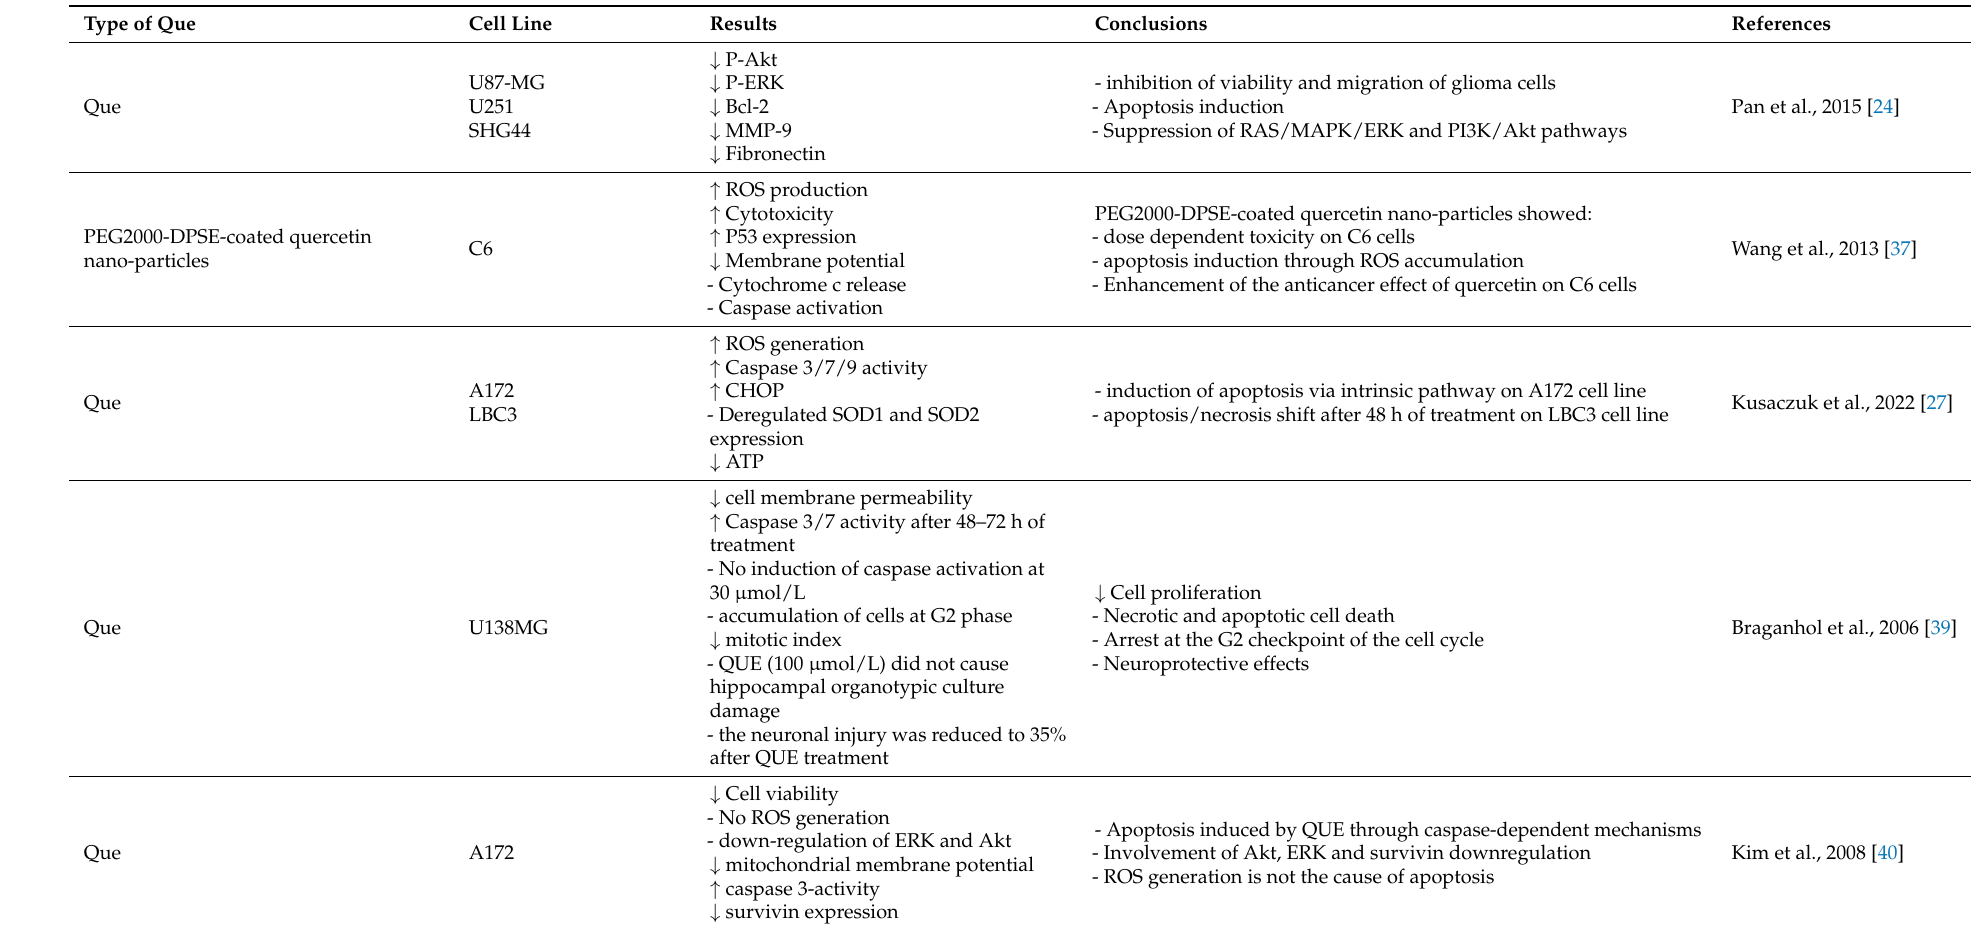
Table 1. An overview of some studies on quercetin’s mechanism of action in tumor cell